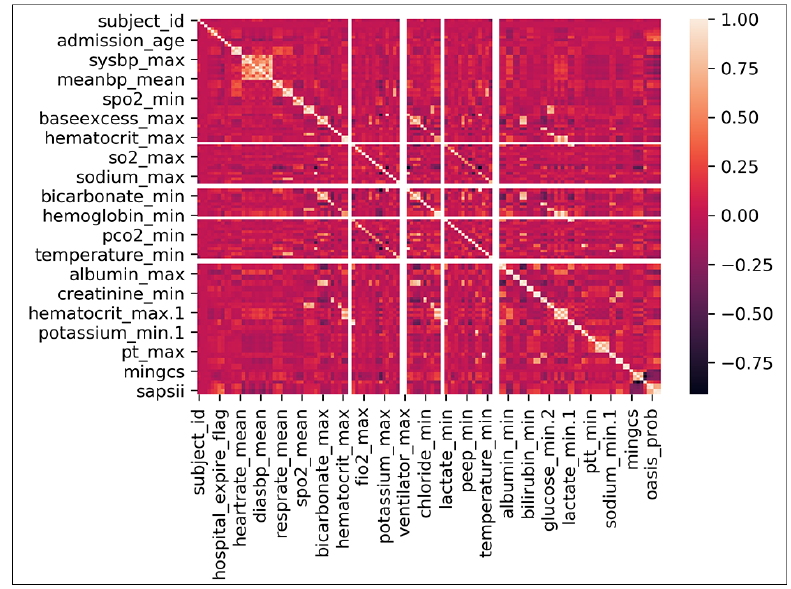
Figure 4. Correlation matrix of all variables selected for